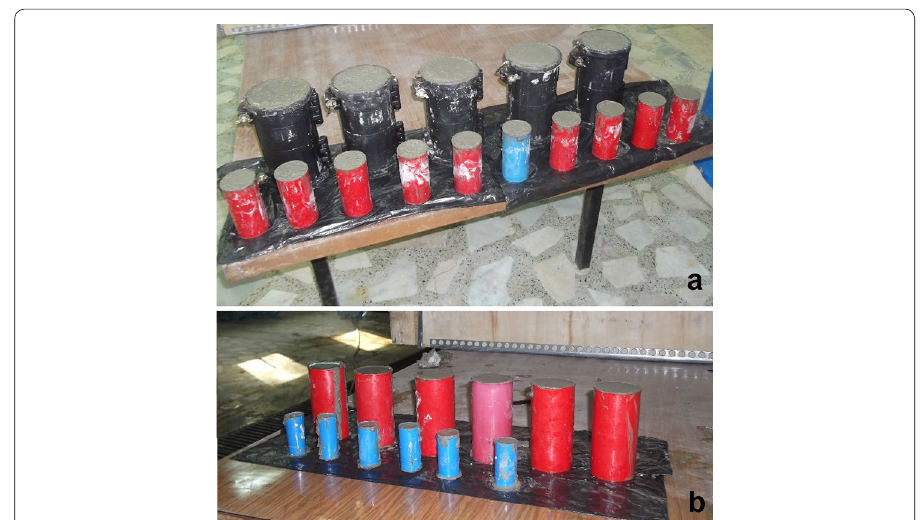
Fig. 3 Molded cementitious mixes: Rocklike 1 ( a ) and Rocklike 2 ( b ) specimens